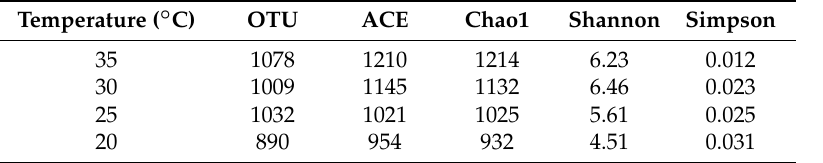
Table 3. Alpha-diversity in the acidogenic phase at different temperatures.